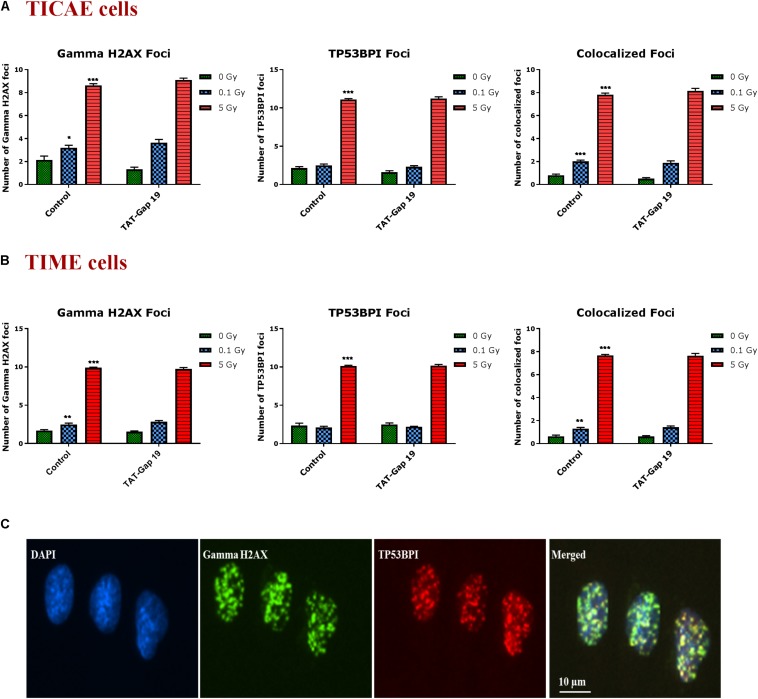
Radiation-induced endothelial DNA damage and effect of TAT-Gap19. Gamma H2AX foci, TP53BPI foci and the colocalized Gamma H2AX/TP53BPI foci were assessed in (A) TICAE cells and (B) TIME cells at 1 h after 0.1 and 5 Gy of X-ray exposure with or without applying TAT-Gap19. (C) Representative images showing gamma H2AX foci (green), TP53BPI foci (red) and colocalized gamma H2AX/TP53BPI foci (yellow) in DAPI stained nuclei of TICAE cells at 5 Gy dose. The values represent the average ± SEM of eight biological replicates; statistical significance was analyzed with a non-parametric Mann–Whitney T-test. *Indicates statistically significant differences compared to the respective 0 Gy controls. •Indicates statistically significant differences in the TAT-Gap19 group compared to the corresponding responses in the control group (not treated with TAT-Gap19). */•p < 0.05; **/••p < 0.01., ***/•••p < 0.001.